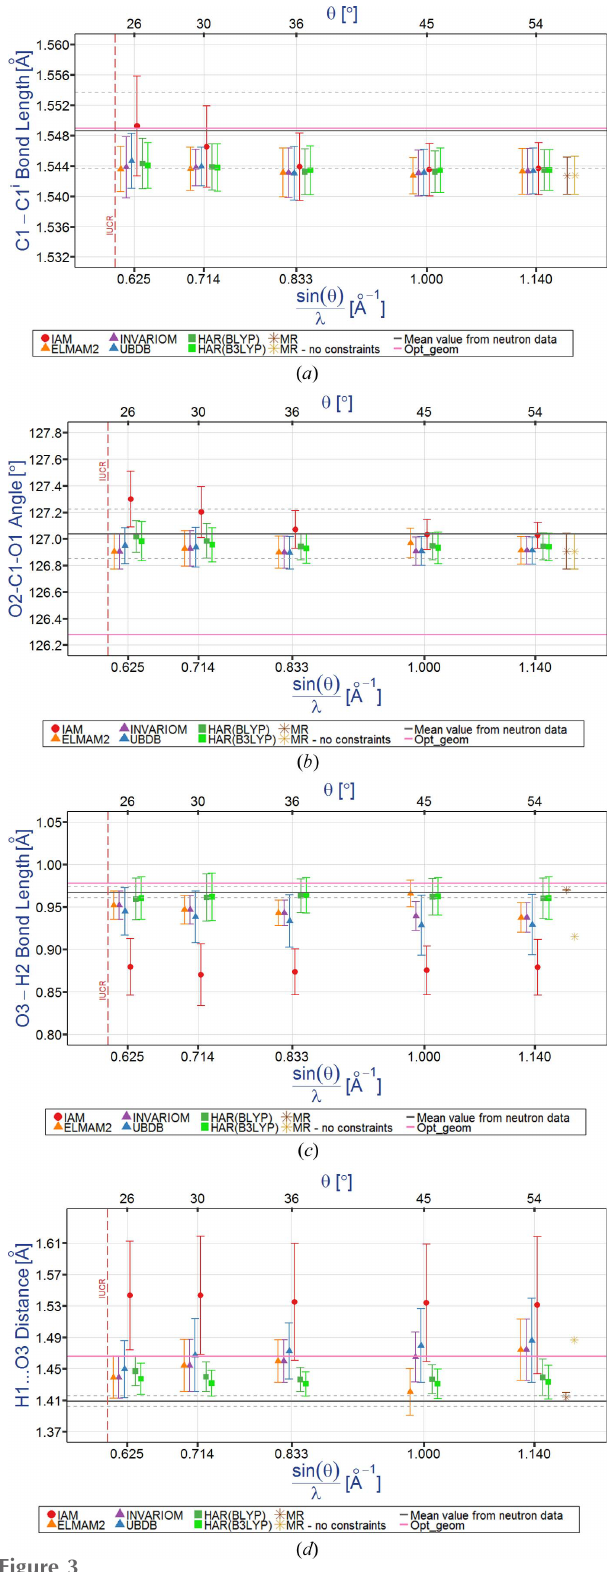
Figure 3 Typical dependencies of geometrical parameters on data resolution and electron density model refined against X-ray and neutron data for: ( a ) the C1—C1 bond length, ( b ) the O2—C1—O1 valence angle, ( c ) the O3—H2 and ( d ) H1—O3 bond lengths. Neutron data and results of periodic DFT calculations are given for the purpose of